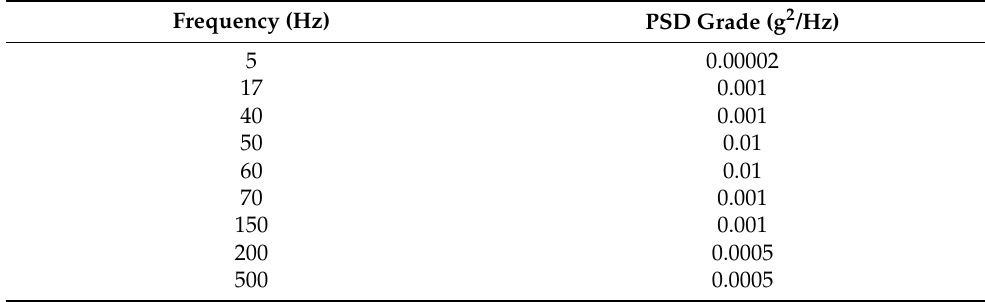
Table 1. Random vibration power spectral density